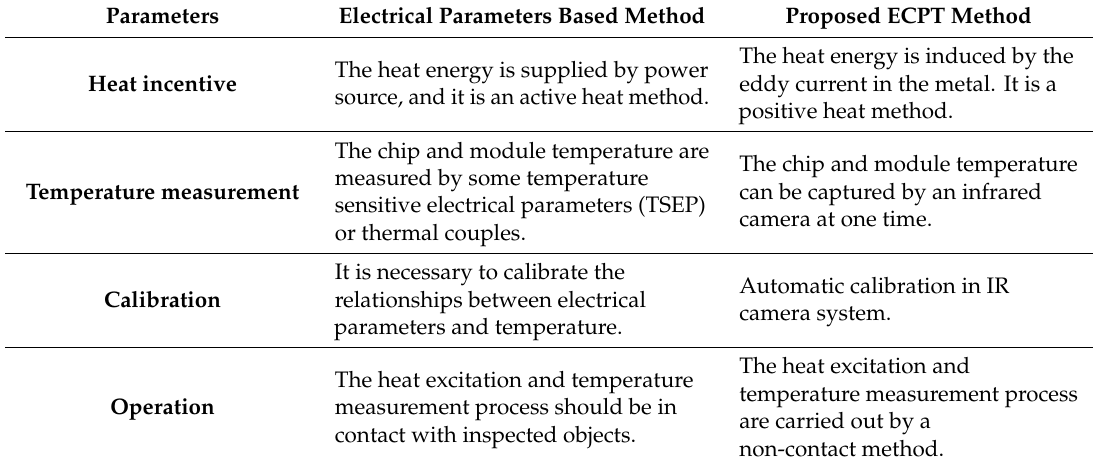
The heat energy is induced by the eddy current in the metal. It is a positive heat method. The chip and module temperature can be captured by an infrared camera at one time. Automatic calibration in IR camera system. The heat excitation and temperature measurement process are carried out by a non-contact